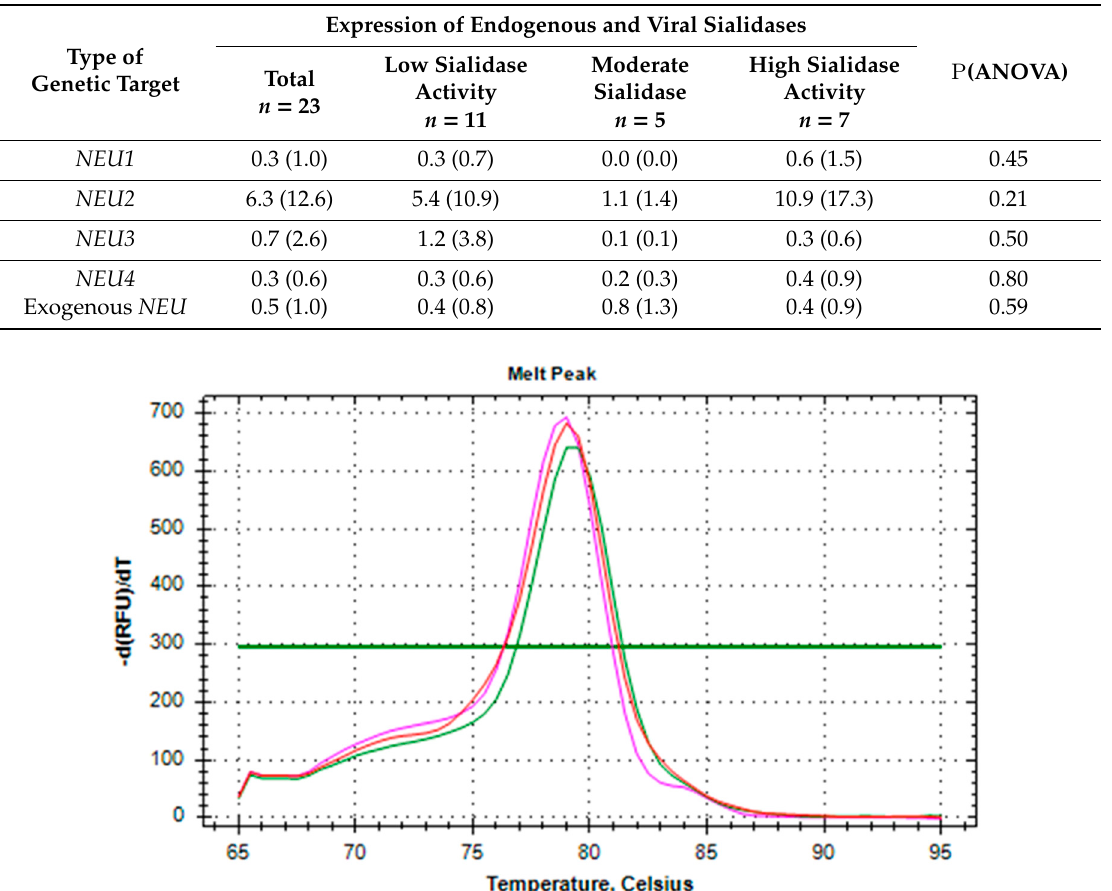
Figure 2. Specificity of qPCR analysis of exogenous sialidase expression indicated by single melt peak after thermal denaturation of amplicons with SYBR Green I.